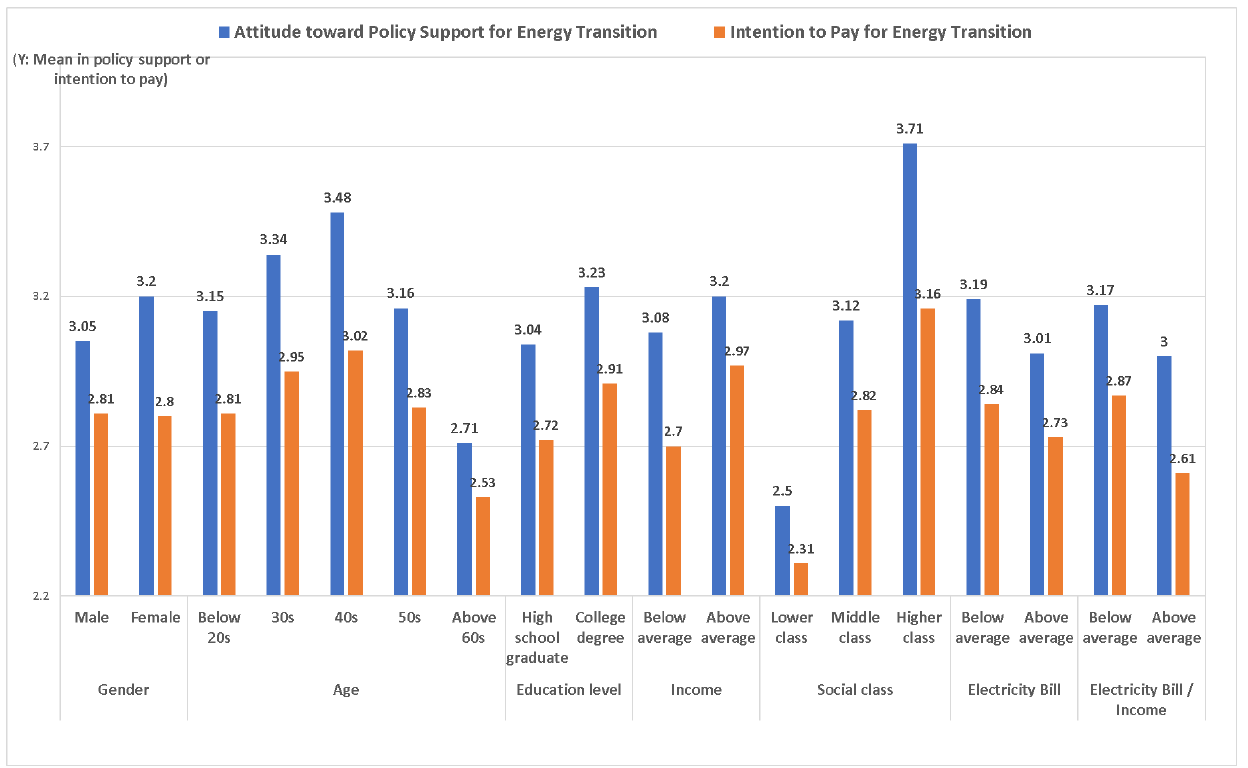
Figure 2. Mean difference in the sociodemographic group.